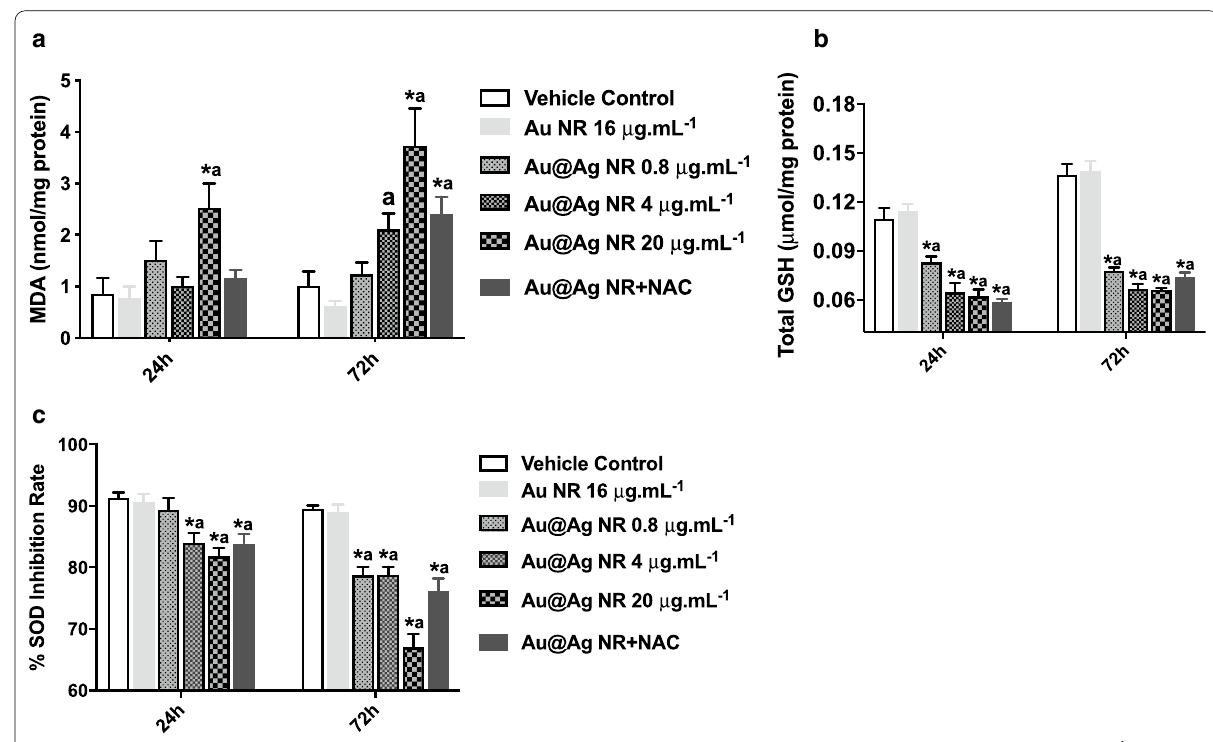
Fig. 5 Effects of Au@Ag NR on the ROS formation. HepaGR cells were exposed to Au@Ag NR at different concentrations from 0.8 μg mL − 1